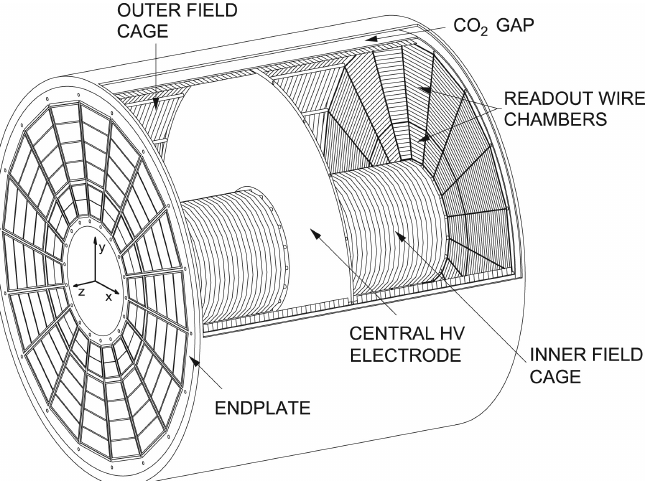
Figure 43. Diagram of the ALICE TPC, from Ref. [96]. The drift HV cathode is located at the center of the TPC, defining two drift volumes, each with 2.5m of drift along the axis of the cylinder toward the endplate. The endplates are divided into 18 sectors, and each endplate holds 36 readout chambers.